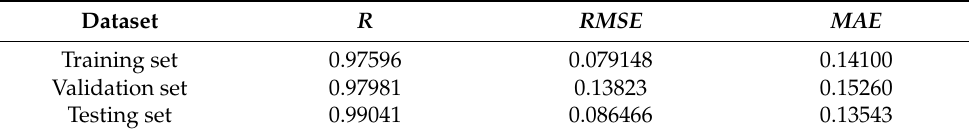
Table 5. Artificial Neural Network Results.